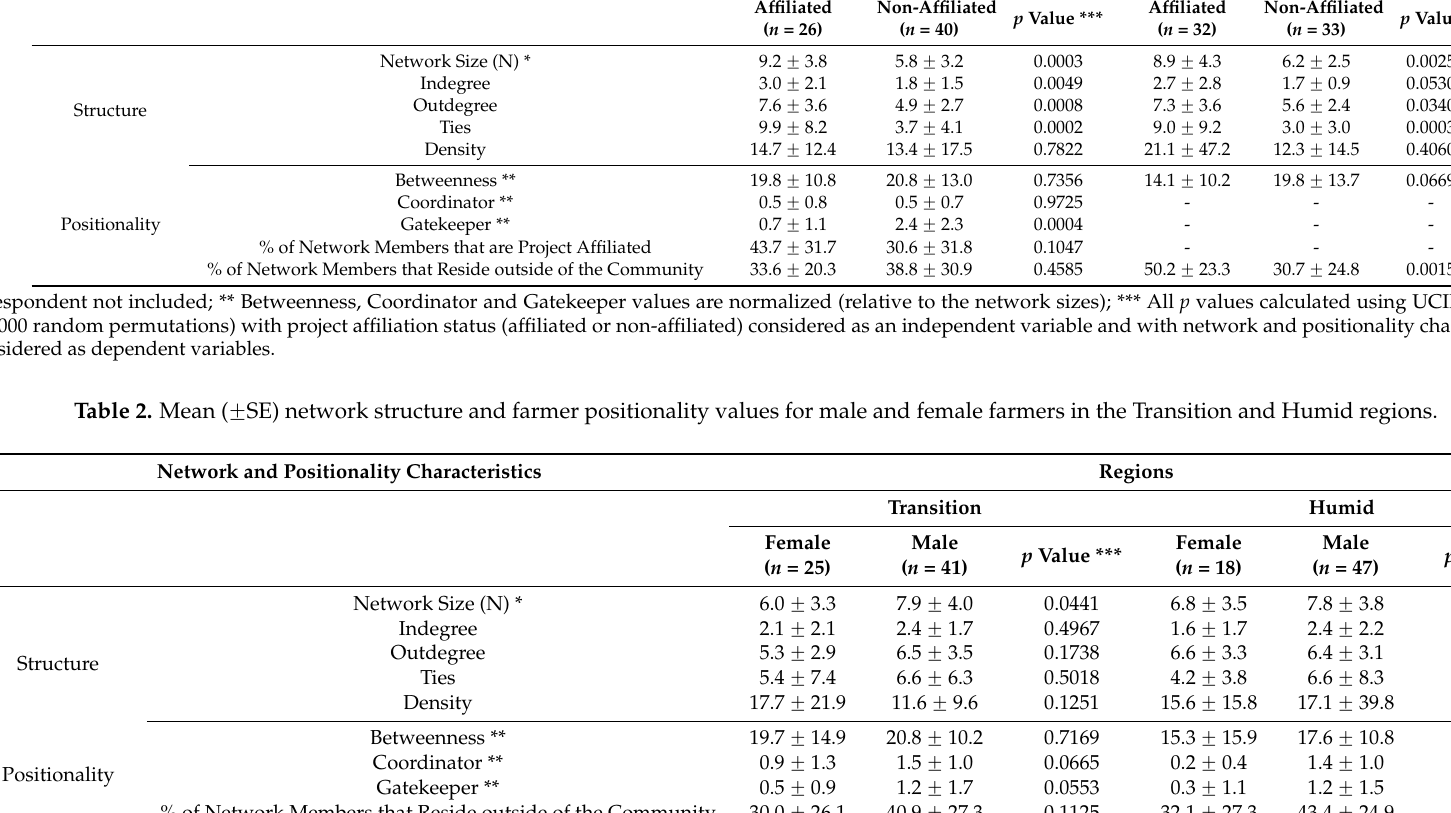
Table 1. Mean ( ˘ SE) network structure and farmer positionality values for affiliated and non-affiliated farmers in the Transition and Humid regions. Network and Positionality Characteristics